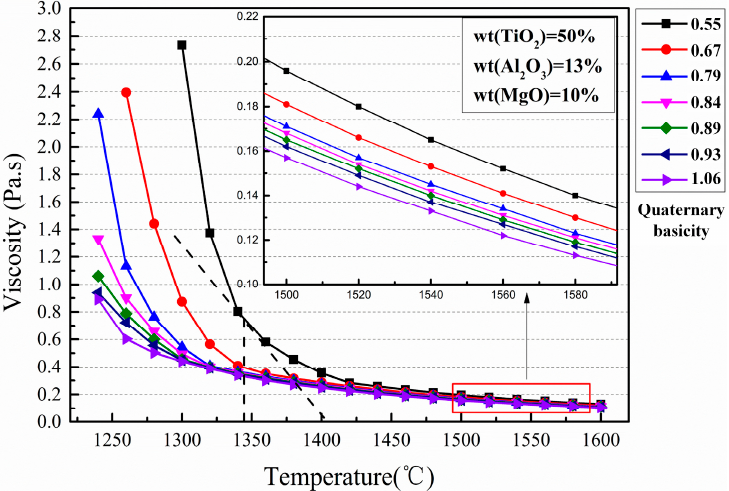
Figure 5. Effects of quaternary basicity by addition of CaO on titanium slag viscosity (FactSage 7.0).